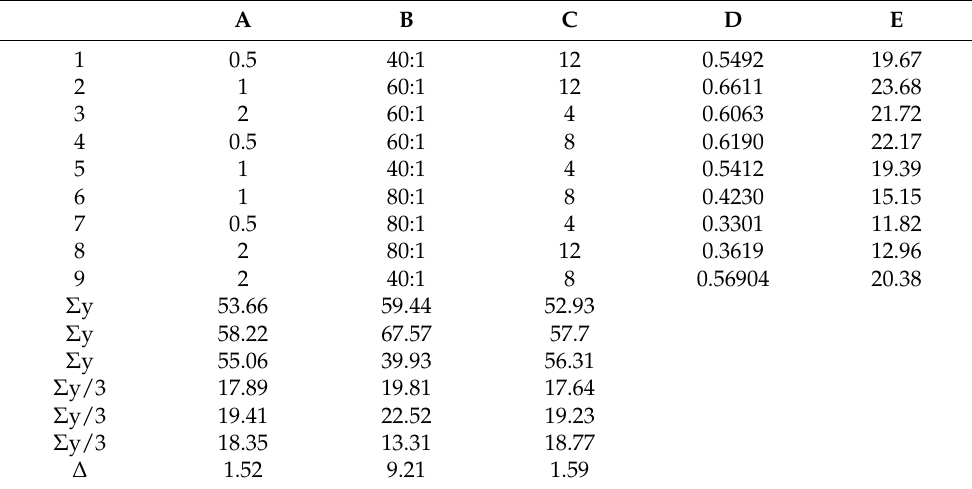
Table 1. Results and analyses of the orthogonal